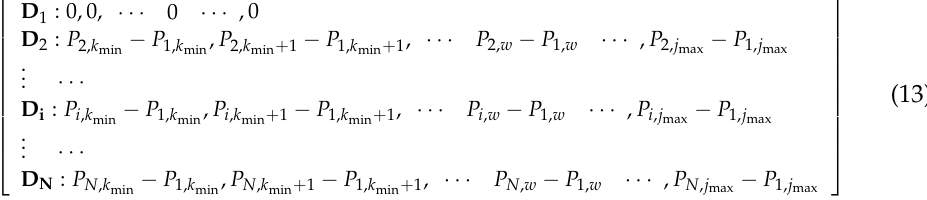
k . Figure 5. Process used to decide k Figure 5. Process used to decide min . min 2. The most-unfavorable working condition II: The simultaneous uneven deformation of PS points on adjacent piers may cause damage to the bridge. The uneven deformation of adjacent piers to obtain the specific damage location and occurrence time, based on the damage time interval, and determined from the most-unfavorable working condition I should be further